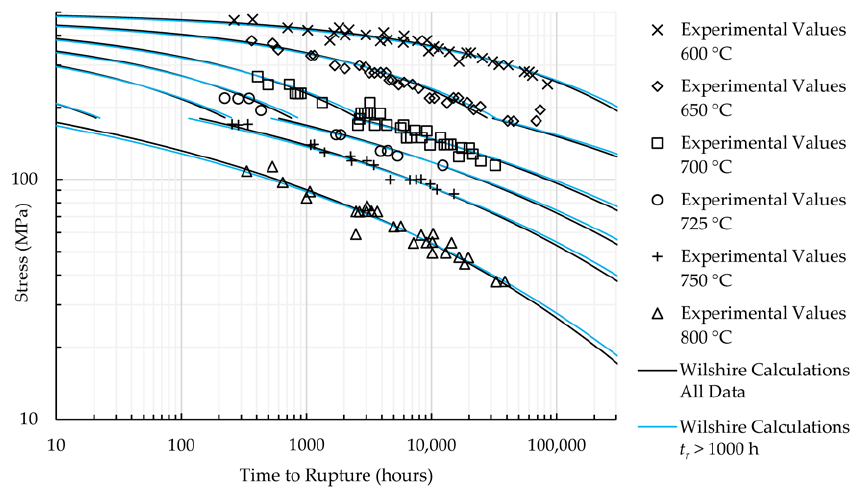
Figure 10. Sanicro 25 Wilshire equation calculations.